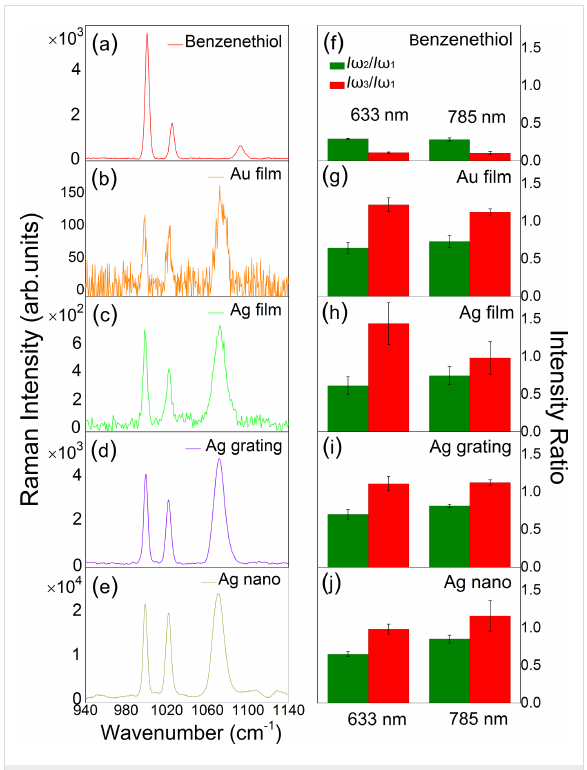
Figure 2: Raman spectra of benzenethiol on different substrates for 633 nm excitation (corresponding data for 785 nm excitation, see Sup- porting Information File 1). (a) Liquid benzenthiol, (b) Au film, (c) Ag film, (d) Ag grating, and (e) Ag nanostructure. (f–j) Corresponding in- tensity ratios of the ω 2 and ω 3 modes normalized to the ω 1 modes for both 633 nm and 785 nm excitation. Each data set is the average from measurements at ten different sample locations. The error bars repre- sent the standard